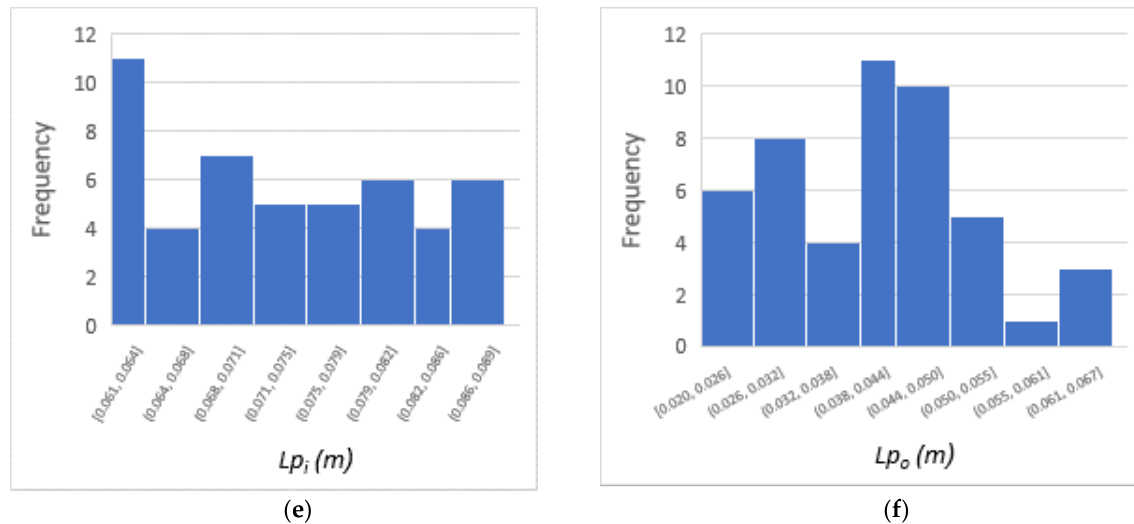
Figure 7. Distribution of second stage design variables: ( a ) leading edge of inlet port; ( b ) leading edge of outlet port; ( c ) inlet port angular width; ( d ) outlet port angular width; ( e ) inlet port length; ( f ) outlet port length.